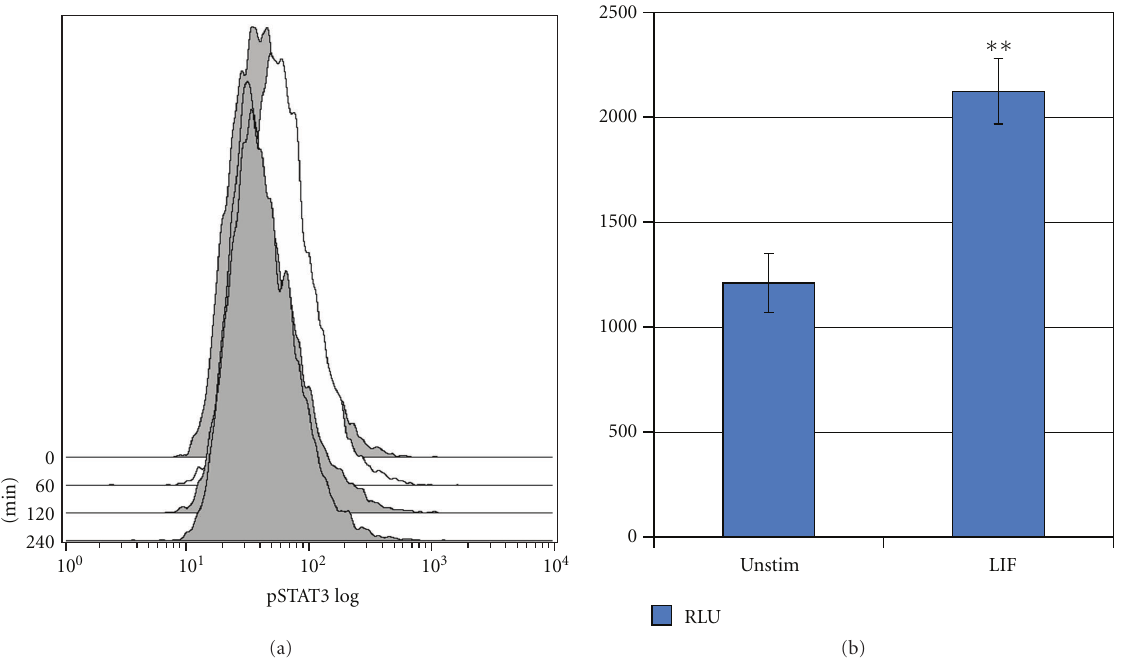
Figure 2: (a) SiHa cells were stimulated with LIF (10ng/mL) for the times indicated (in minutes), and the level of phospho-STAT3(y705) measured. STAT3 is transiently phosphorylated following stimulation with LIF within 60 minutes, returning to baseline level by 120 minutes. Histograms are colored according to the log 10 -fold increase in mean fluorescence intensity relative to unstimulated cells. (b) CaSki cells transfected with a STAT3 reporter plasmid were treated with 50 ng/mL LIF for 6 hours prior to assay. The increase in relative light units is shown. Error bars represent standard error of the mean. Asterisks represent significance ( ∗∗ P < . 05).